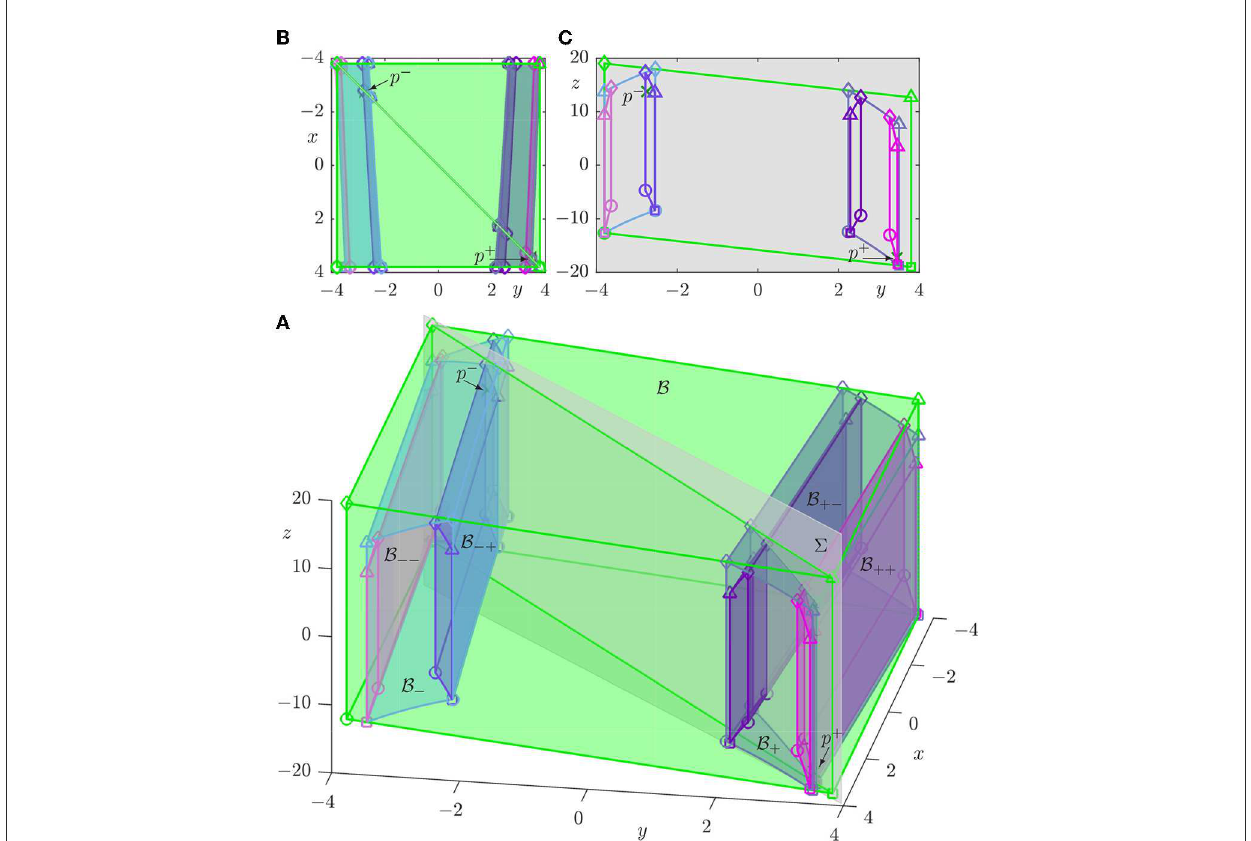
FIGURE2 Box B (green) for ξ = 1.2 with its two preimages B − (light blue) and B + (dark blue) and their four preimages B −− (light magenta), B −+ (light purple), B +− (purple), and B ++ (magenta). (A) shows these objects in ( x , y , z )-space, together with p ± (green crosses) and the diagonal plane 6 (gray). (B) is the top view in the ( x , y )-plane oriented as in (A) , and (C) shows the intersecting (approximate) parallelograms in 6 ; note that 6 is represented here by its projection onto the ( y , z )-plane. Compare with Figure